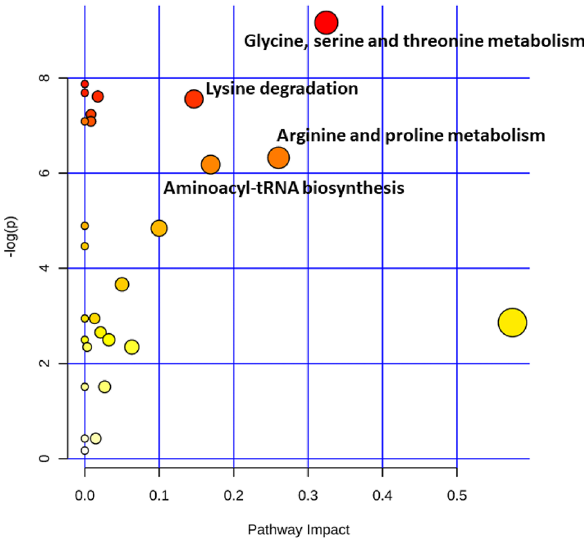
Figure 1. The results of pathway analysis depicting the metabolome view, displaying all the matched pathways as circles. The color is based on its p value and size of each circle on its pathway impact value.